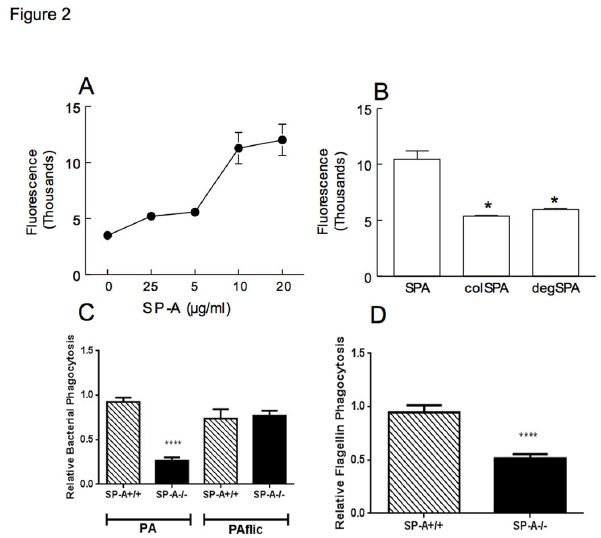
Figure 2. SP-A Binds Flagellin and Enhances Macrophage Phagocytosis. Fluorescently labeled SP-A bound to flagellin in a dose dependent manner (A). Binding of SP-A to flagellin was reduced in the absence of the collagen-like domain (colSPA) or the asparagine-linked carbohydrate moieties of SP-A (degSPA) (B); p<0.05 when compared to undigested SP- A. Phagocytosis of wild type PA was reduced, however phagocytosis of the fliC strain was similar between SP-A+/+ and SP-A-/- macrophages (C). Phagocytosis of flagellin by SP- A-/- alveolar macrophages was decreased compared to SP-A +/+ mice (D). Values for panel C were obtained from n=8 mice in each case combined from 2 experiments. Values in panel D were obtained from 4 mice combined from 2 experiments. One value for the SP-A+/+ mice in each experiment was normalized to 1, and other values are expressed relative to this normalization; p<0.0001 relative to the SP-A+/+ sample in each comparison by student’s t-test.